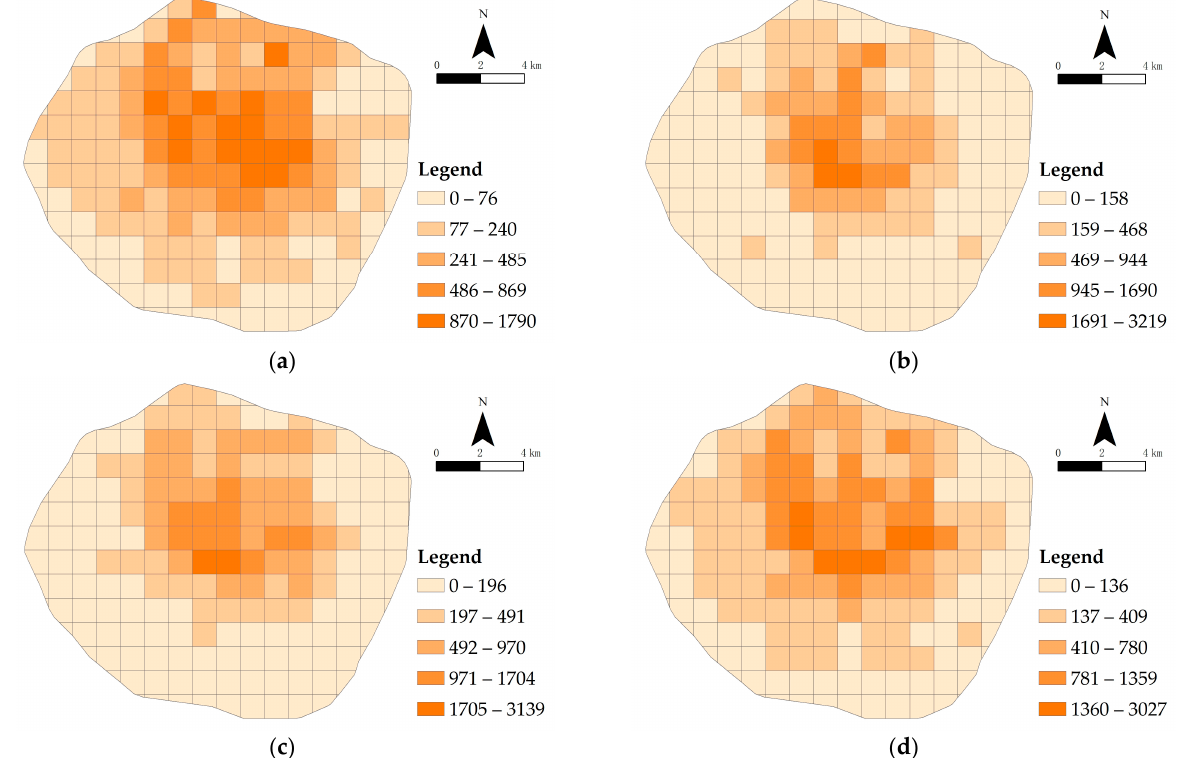
Figure 5. The distribution of ride-hailing pick-ups and drop-offs in Chengdu. ( a ) Pick-ups in the morning peak hours; ( b ) drop-offs in the morning peak hours; ( c ) pick-ups in the evening peak hours; and ( d ) drop-offs in the evening peak hours.